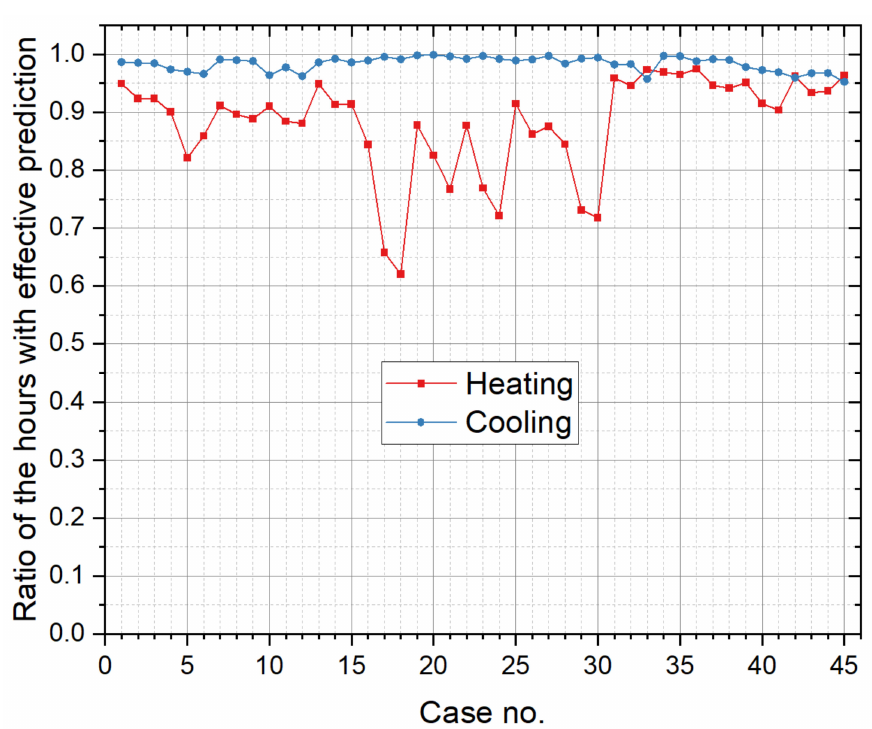
Figure 16. “Ratio of the hours with effective prediction” of 45 test